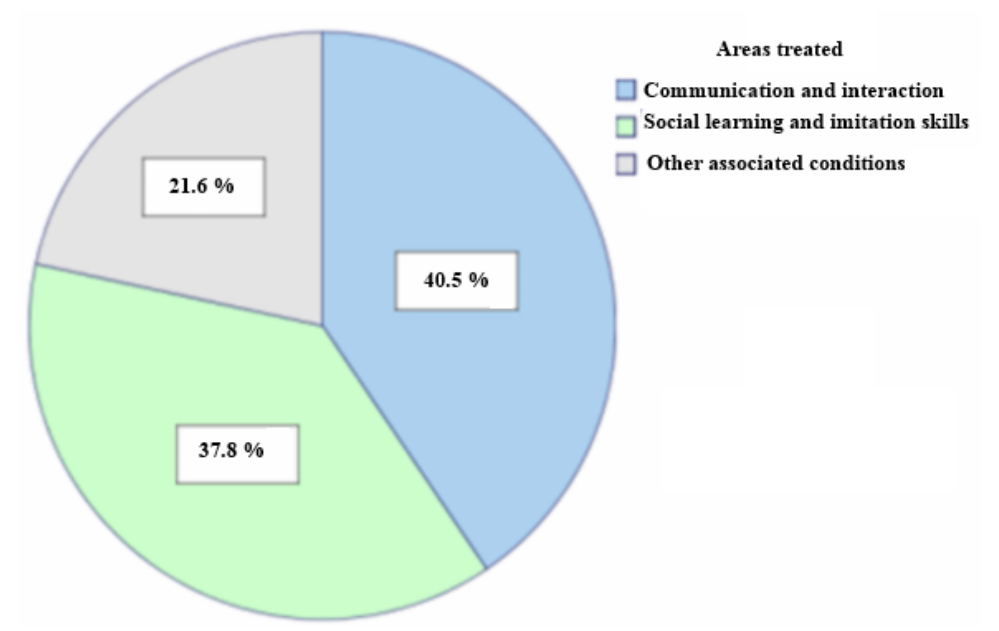
Figure 6. Analysis of the areas treated by using mixed reality, dedicated applications and